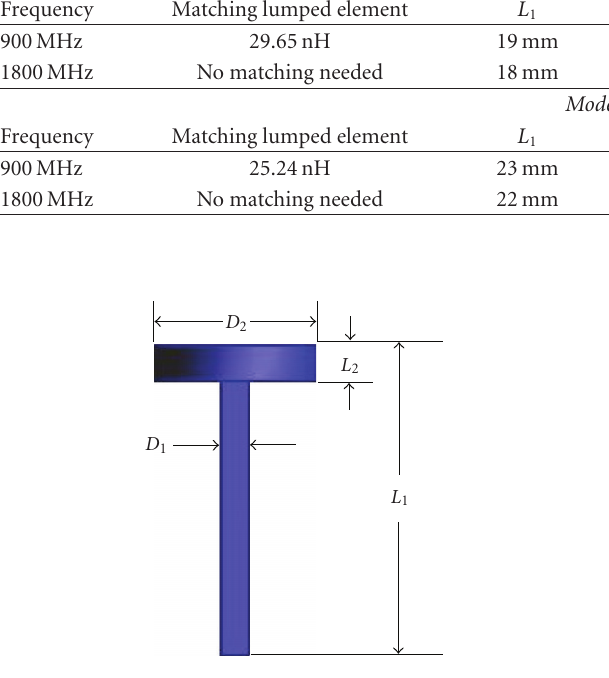
Figure 4: The proposed loaded short-whip antenna with dimen- sions.